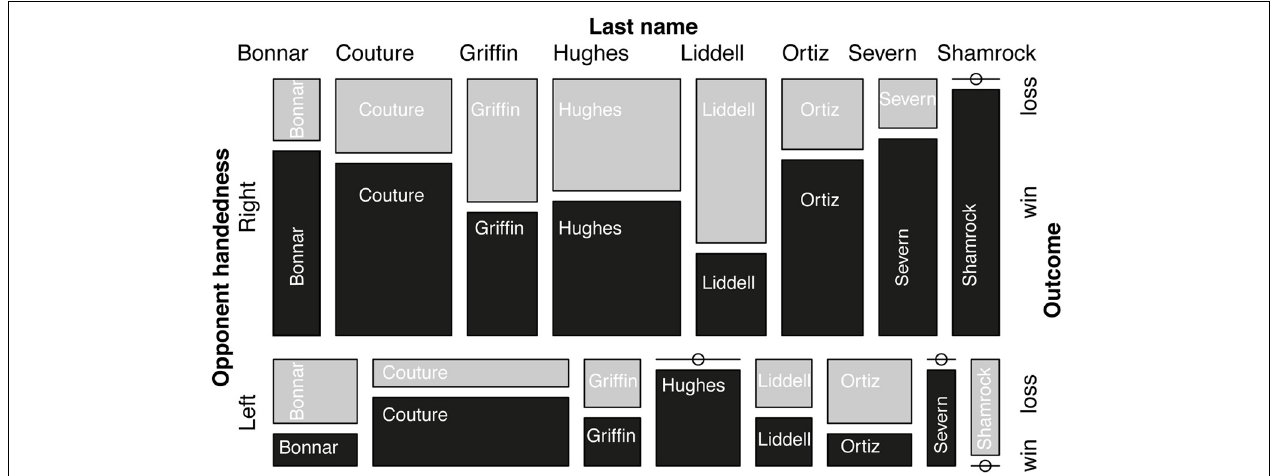
FIGURE 1 | A mosaic plot summarizing all the data (wins are in black, losses in gray; Ø = no data available in that category) (Meyer et al., 2006, 2013; Hofmann, 2008; Wickham and Hofmann, 2011).